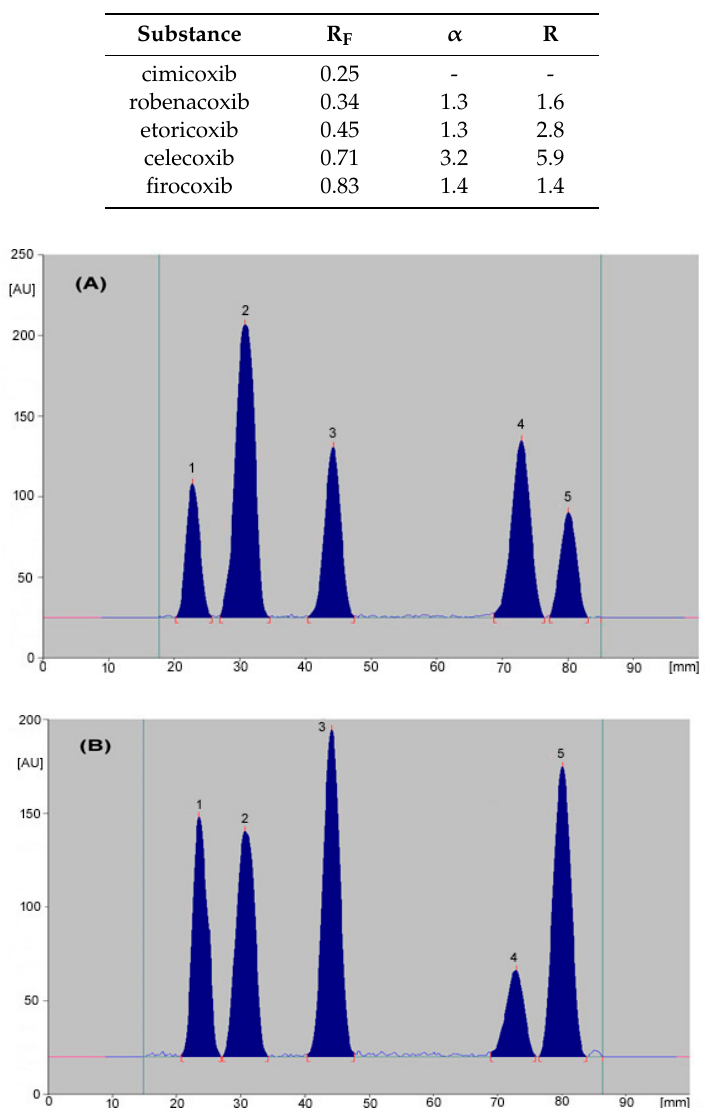
Table 1. Retardation (R F ), resolution ( α ) and separation (R) factors.